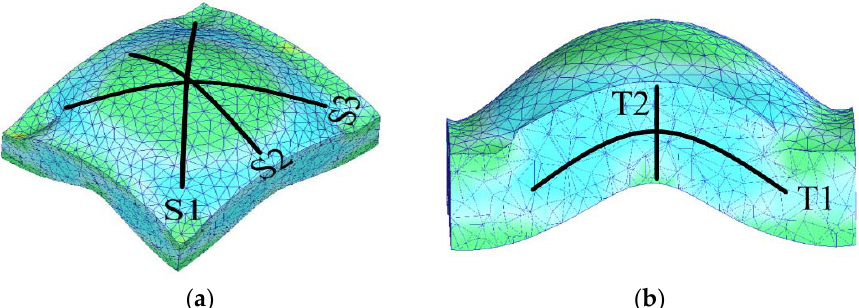
Figure 5. Schematic representation of directions ( a ) S1, S2, and S3 on the top surface and ( b ) T1 and T2 on thickness in the corrugation step from the first pass of the modified ‐ CSP.